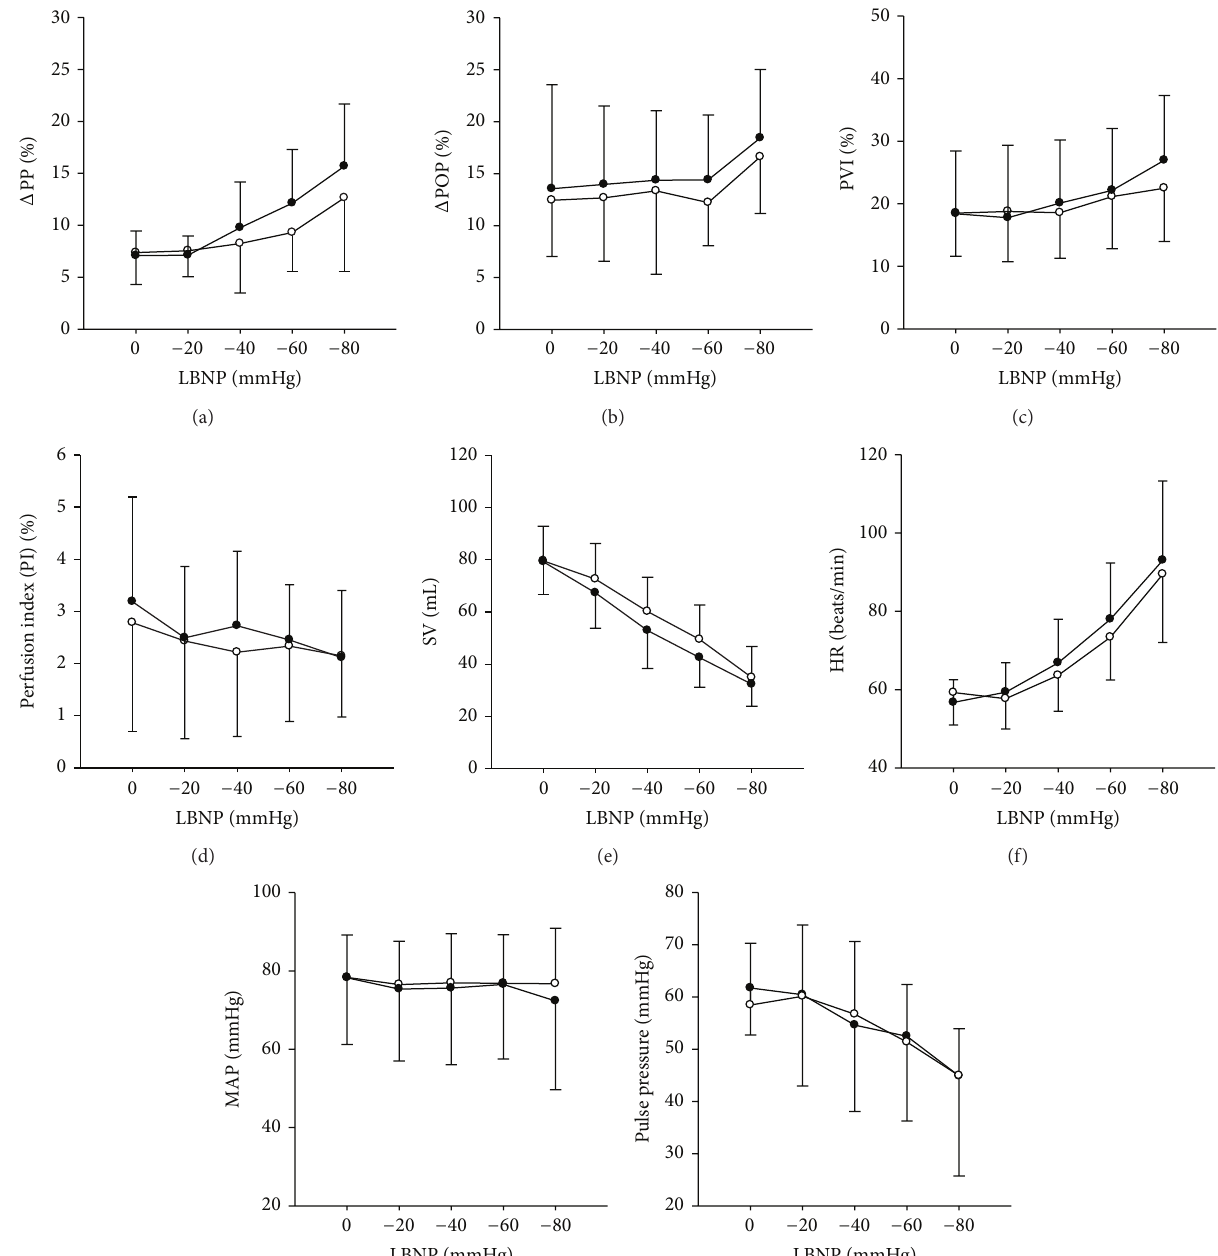
Figure 2: Line charts of mean values at each LBNP-level for Δ PP, Δ POP, PVI, PI, SV, HR, MAP, and PP. Open circle: measurements during spontaneous breathing. Full circle: measurements during NPPV. 1 SD illustrated with one-sided error bars for clarity. Δ PP: respiratory variations in pulse pressure, Δ POP: respiratory variations in the photoplethysmographic waveform amplitude, PVI: pleth variability index, PI: perfusion index, SV: stroke volume, HR: heart rate, MAP: mean arterial pressure, PP: pulse pressure, NPPV: noninvasive positive pressure ventilation, LBNP: lower body negative